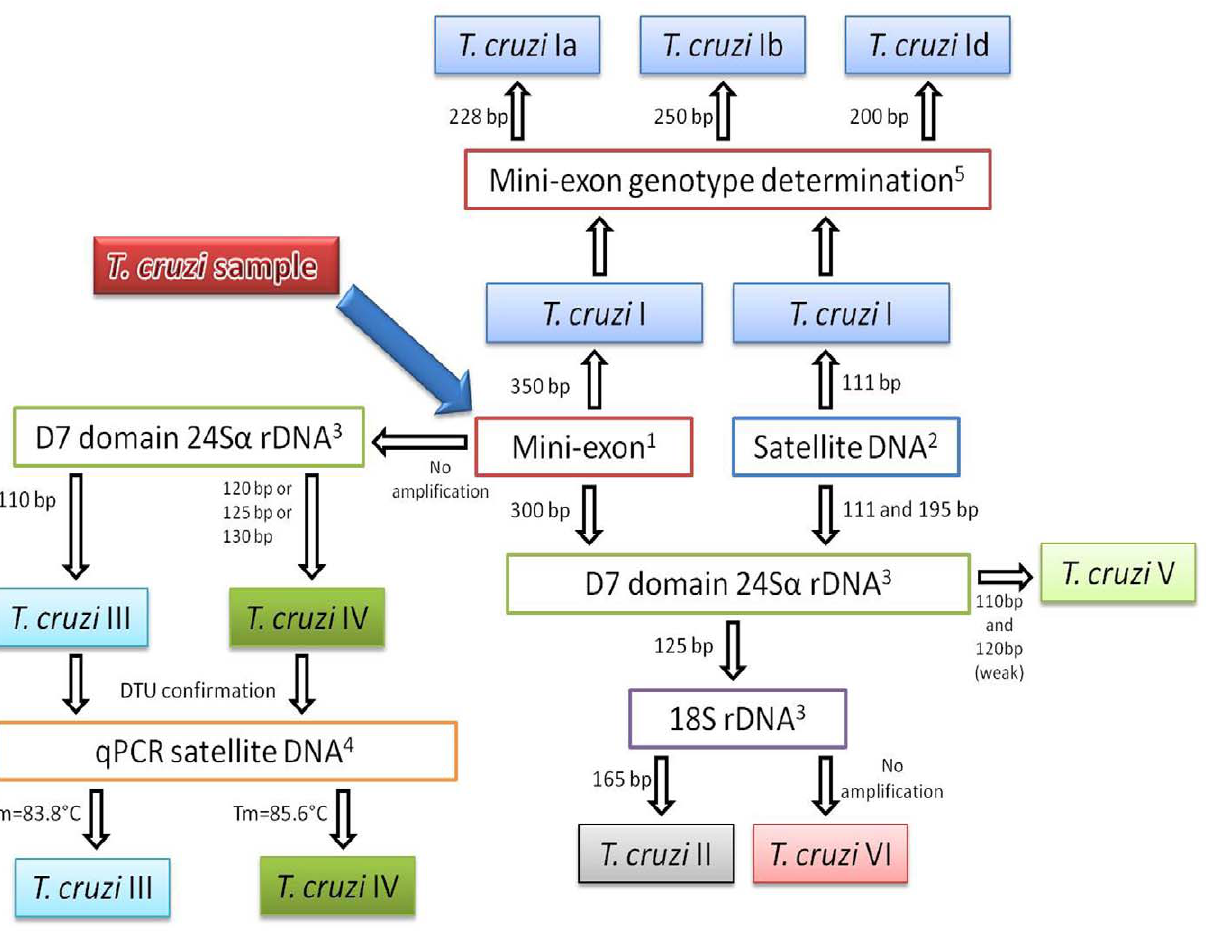
Figure 1. Algorithm for molecular characterization of T.cruzi DTUs based on five molecular markers. 1 Souto et al ., 1996, 2 Liarte et al ., 2009, 3 Brisse et al ., 2000, 4 Duffy et al ., 2009 and 5 Falla et al ., 2009.